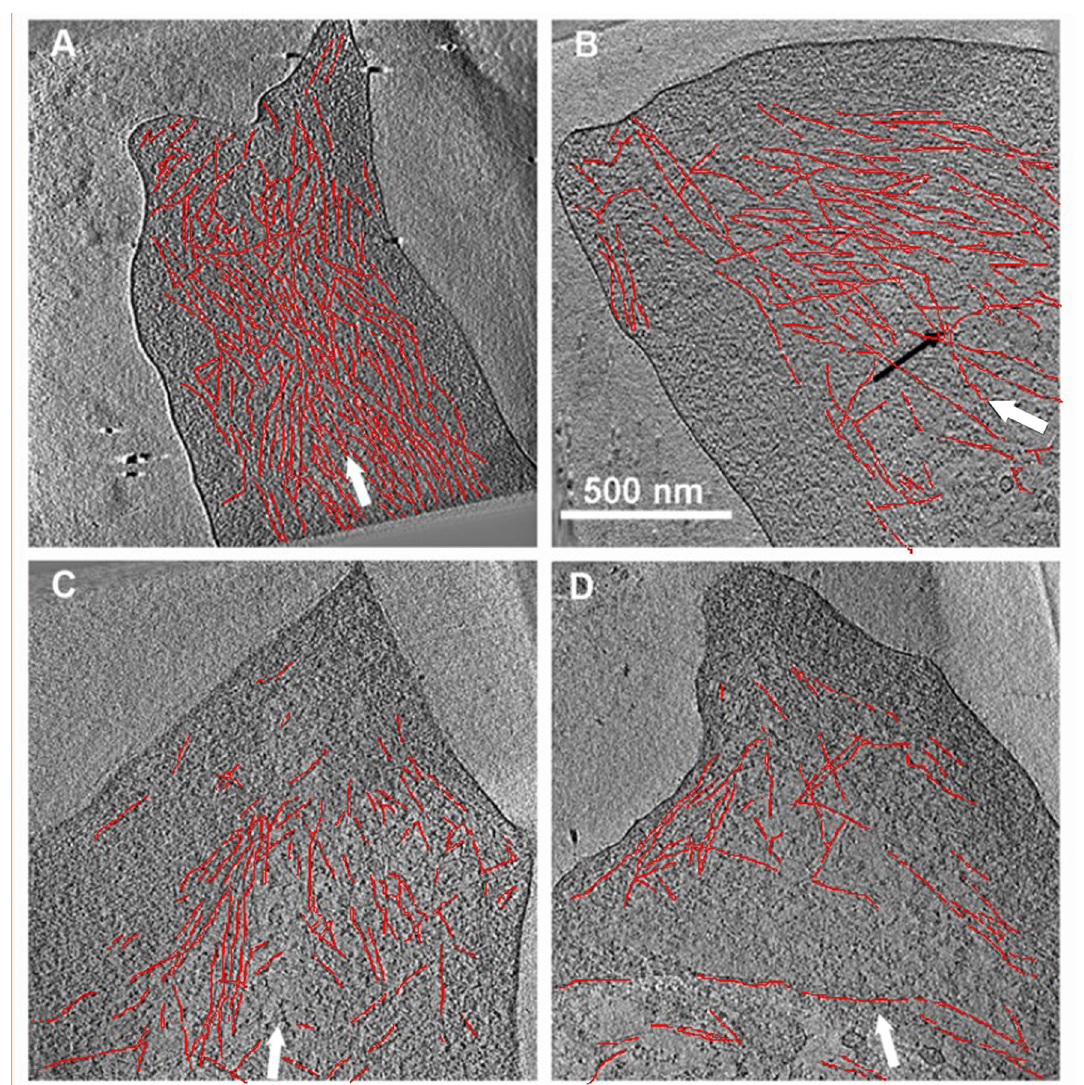
Figure 4. Cryo-electron tomography of cells incubated with Y-27632. REF52 cells expressing YFP-paxillin growing on EM grids, untreated ( A ) or treated for 3 ( B ), 10 ( C ) or 30 ( D ) minutes with Y-27632, were analyzed by correlative (fluorescence-cryo- electron tomography) microscopy. Individual FAs, identified by light microscopy, were subjected to cryo-ET and 3D image reconstruction. The major axis of each FA is indicated by a white arrow; some of the more prominent filaments are highlighted by a thin red line . Ten nm-thick slices through the cryo-tomograms of representative FAs indicated a major reduction in actin alignment, already observed following 3 min treatment with the drug (compare B to A: The black arrow, in B, points to an example of misaligned filaments, commonly seen after Y-27632 treatment). Upon longer treatment with Y-27632, progressive misalignment of actin filaments is apparent, accompanied by a marked reduction in filament density. The scale bar in B represents 500